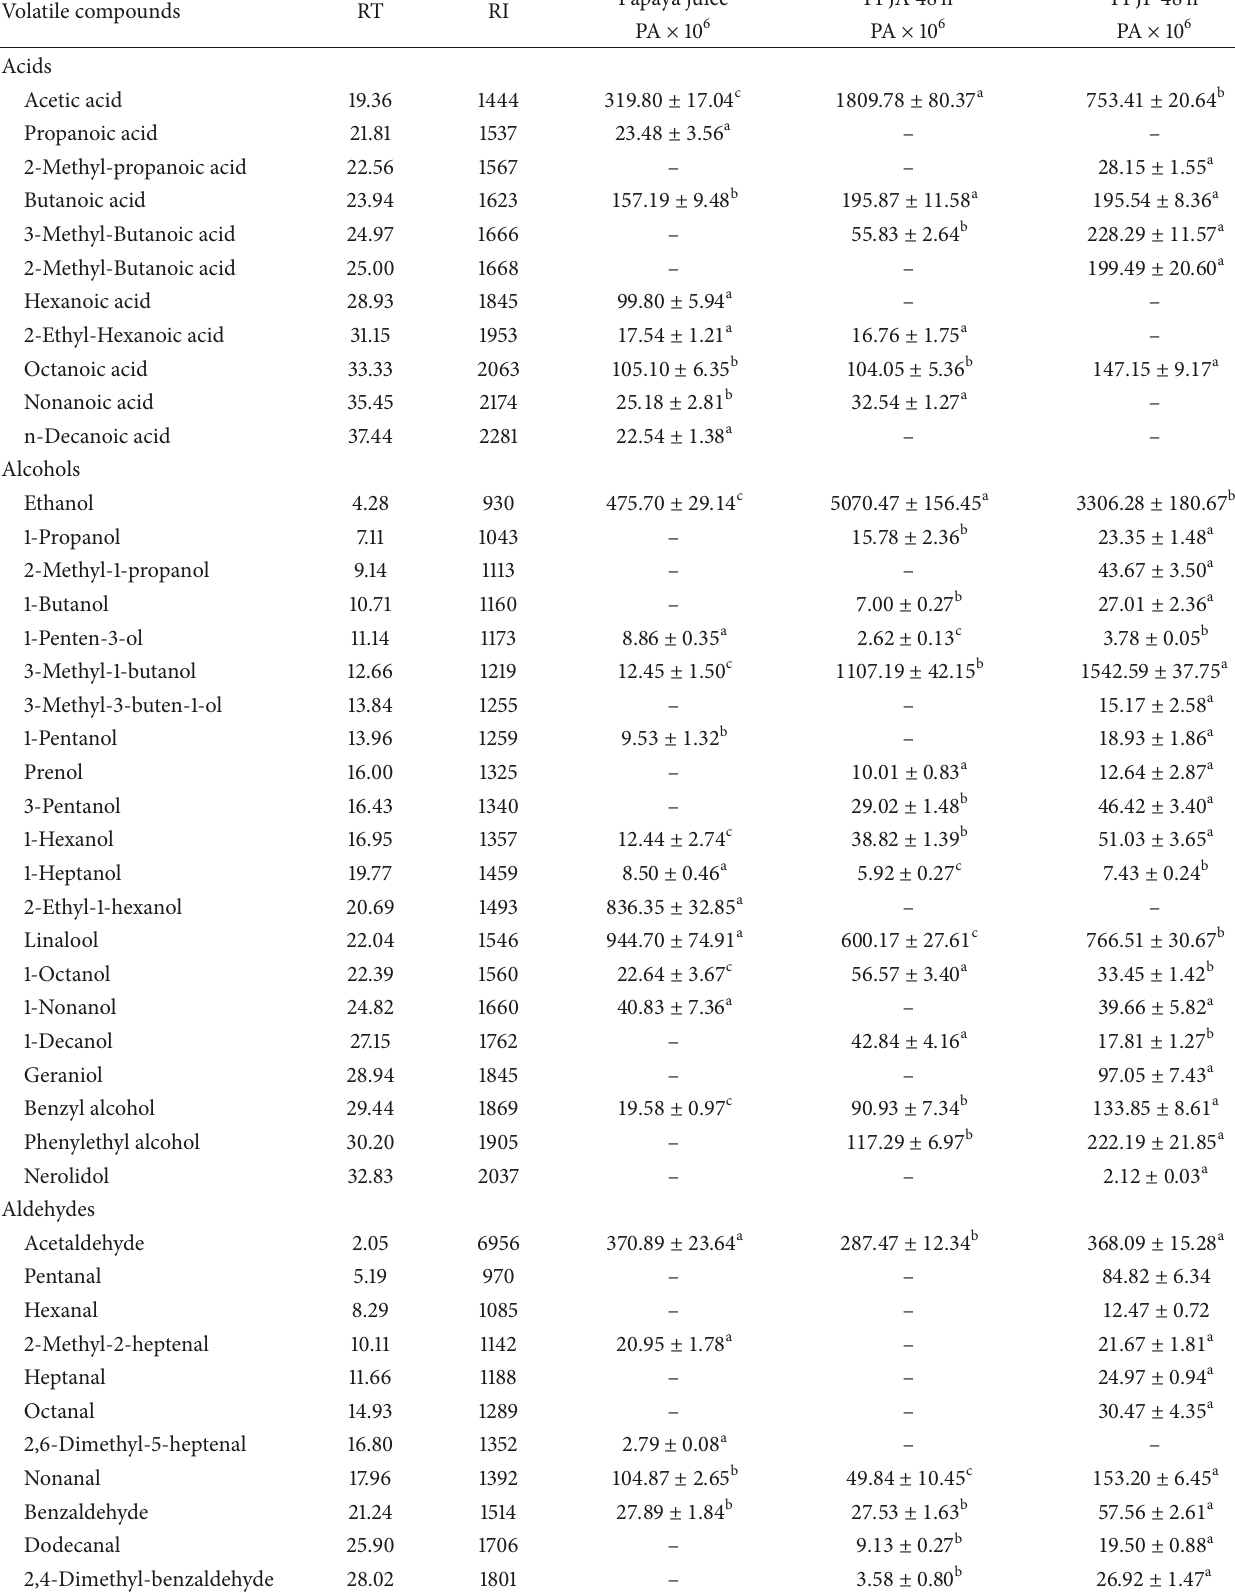
Table 5: Major volatile compounds and relative peak area in papaya juices before and after 48 h